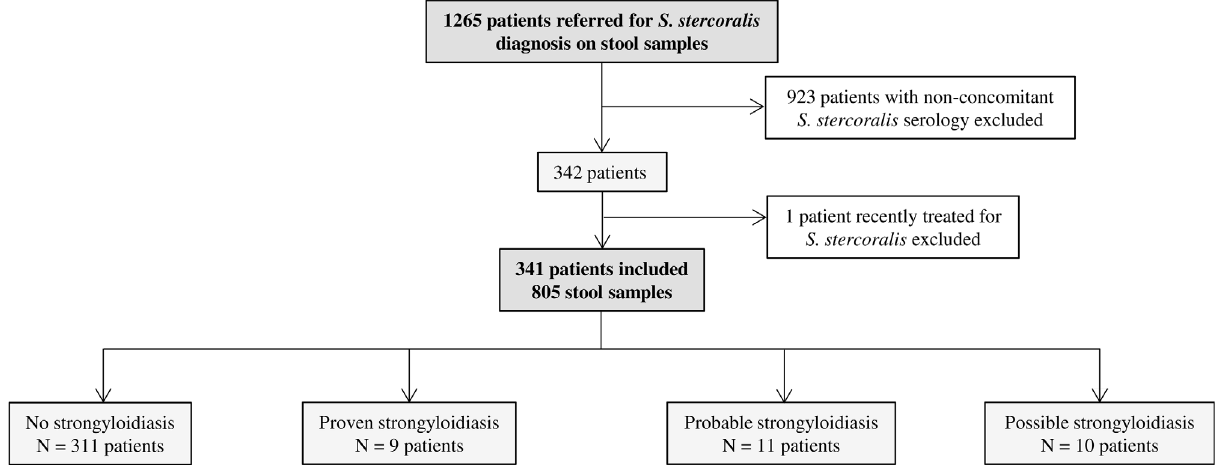
Figure 1. Flowchart of included cases.